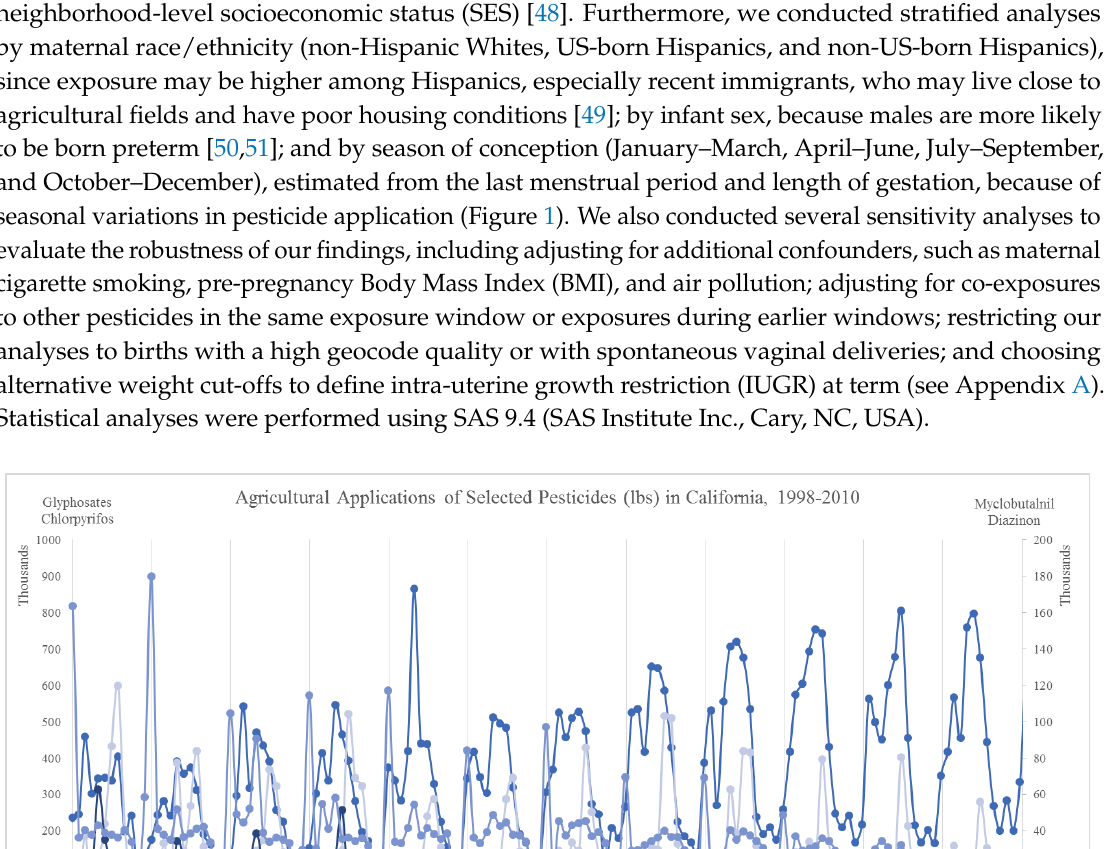
Table 1. Demographic and pregnancy characteristics of the study population in agricultural regions, 1998–2010.